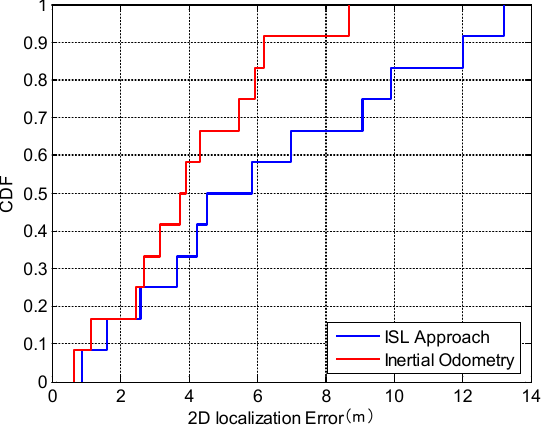
Figure 8. CDF error comparison.